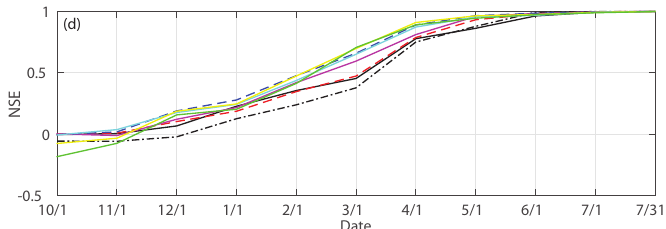
Figure 3. Statistical metrics of median forecasts of the April–July streamflow runoff volume at different issue dates ( a ) rank correlation; ( b ) percent bias (%); ( c ) mean absolute error skill score and ( d ) Nash–Sutcliffe efficiency for the study areas.